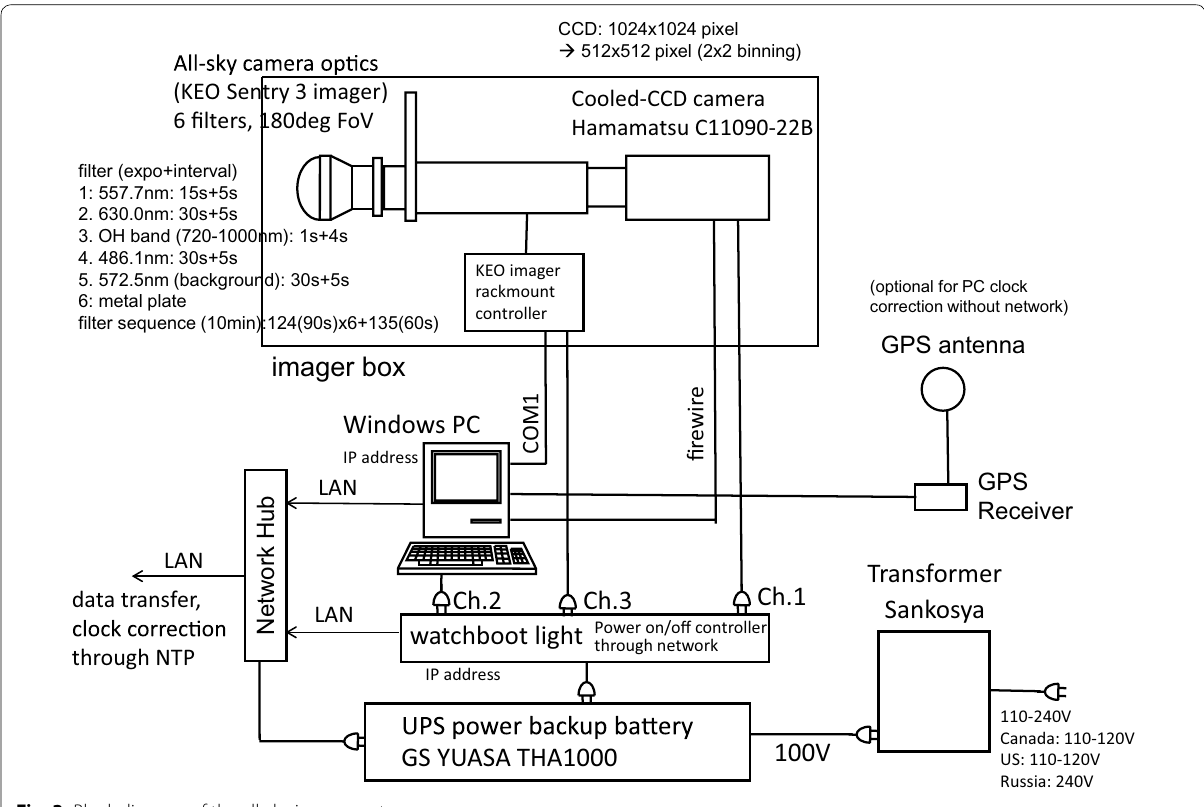
Fig. 3 Block diagram of the all‑sky imager